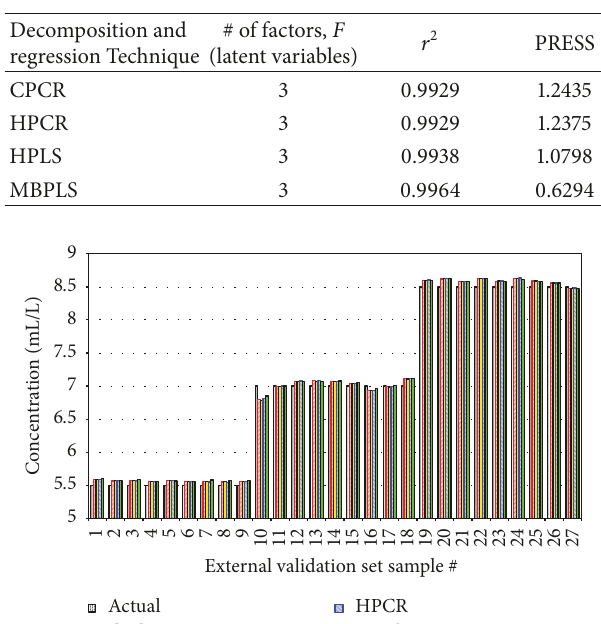
Table 7: 𝑟 2 and PRESS results for take-one-out cross-validation within the training set for 𝐹 = 3 .